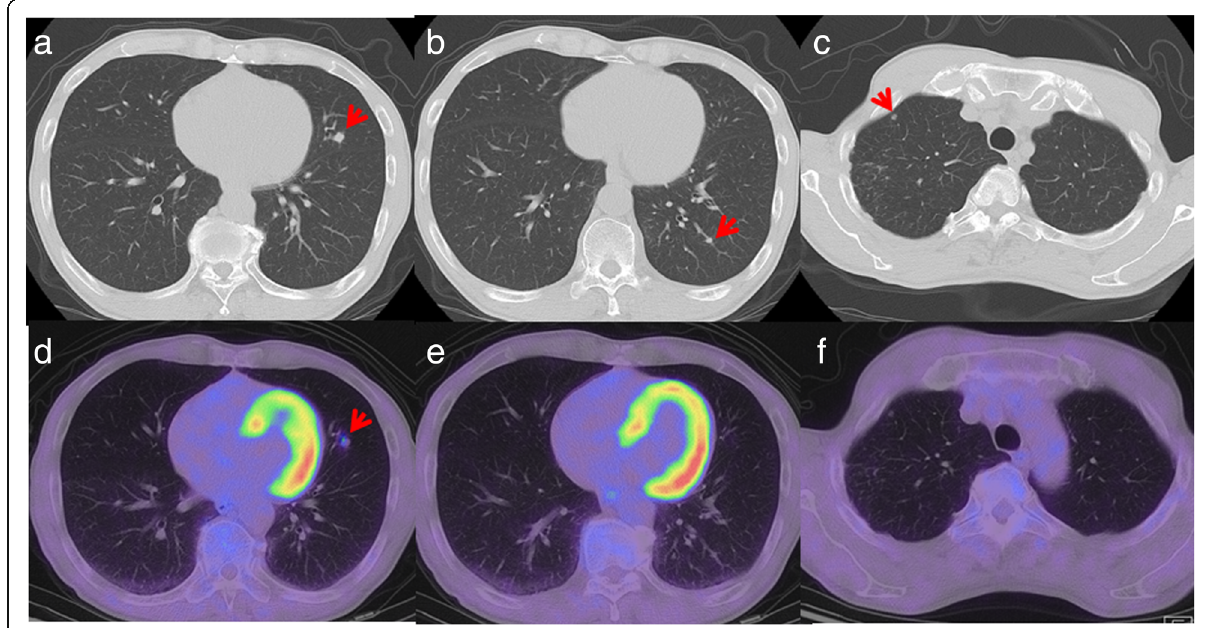
ICC (Fig. 6a). On immunohistochemistry, the carcinoma cells were positive for CK 7 and negative for CK 20 and TTF-1 (Fig. 6b – d). The nodule noted in S1 of the right lung was too small to be diagnosed for metastasis; therefore, it was not resected. After pulmonary resection,